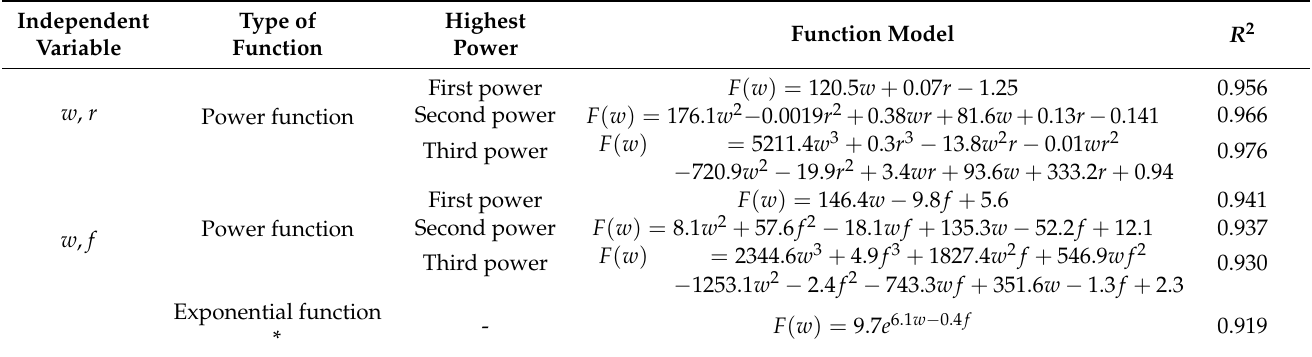
Table 6. Parameters of each fitting